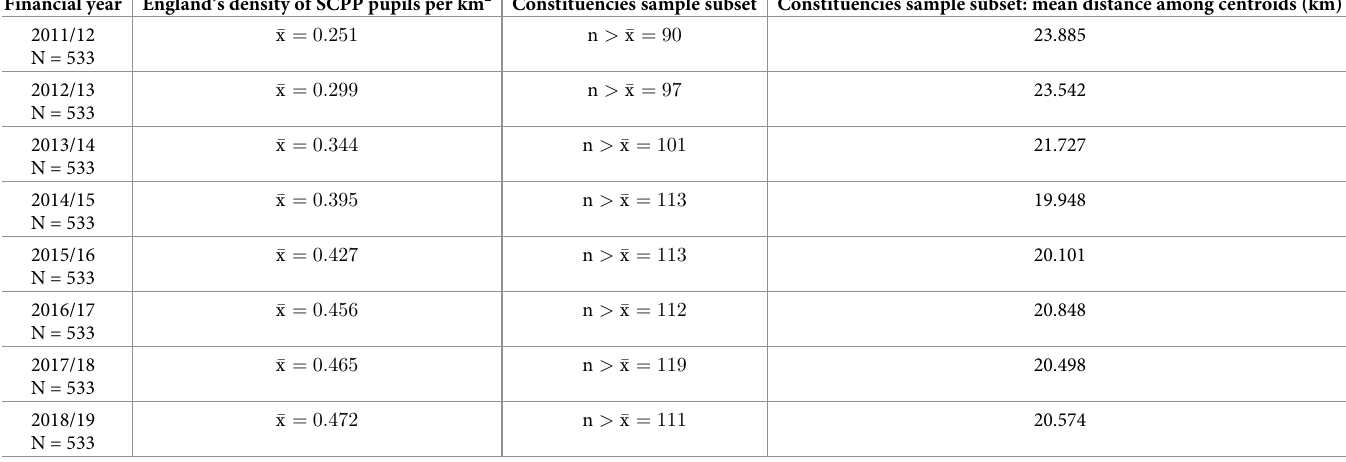
Table 3. Average nearest neighbour